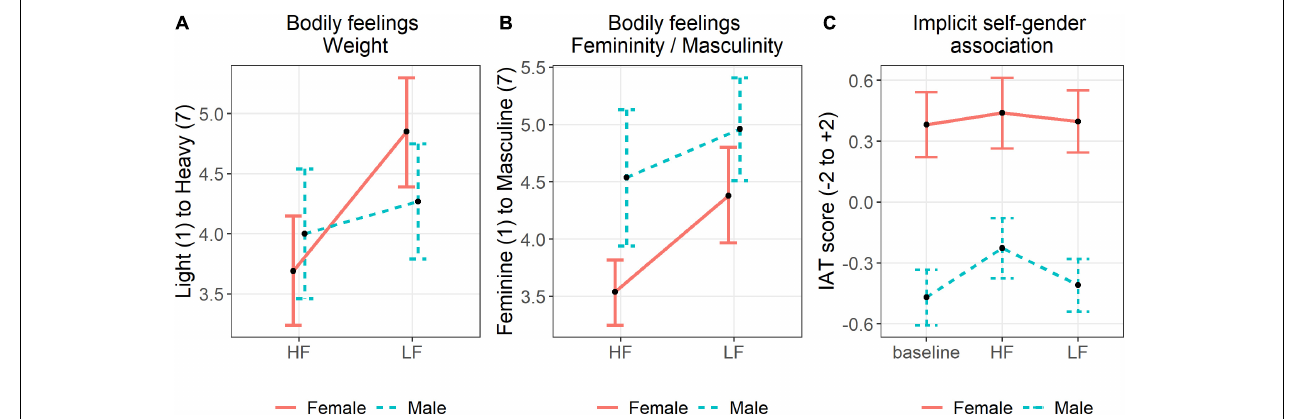
FIGURE 7 | Visualisation of the data from male and female participants after walking with high and low frequency step sounds. (A) Shows mean values of perceived body weight ( n = 51). (B) Shows mean values of perceived masculinity and femininity ( n = 51). (C) shows mean IAT scores where a higher score corresponds to a stronger association with “Female” ( n = 52). Error bars show 95% confidence